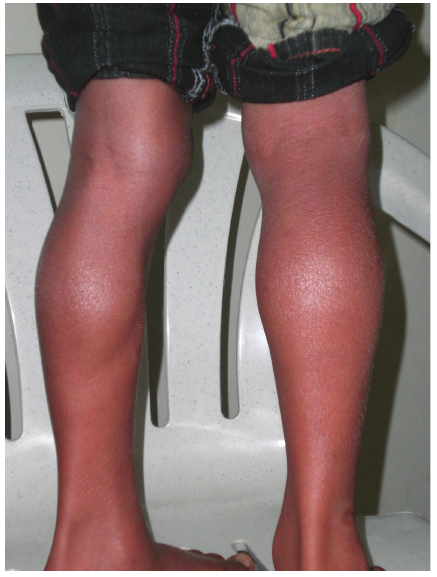
Figure 4: Calf pseudohypertrophy in the same boy with Kocher- Debre-Semelaigne